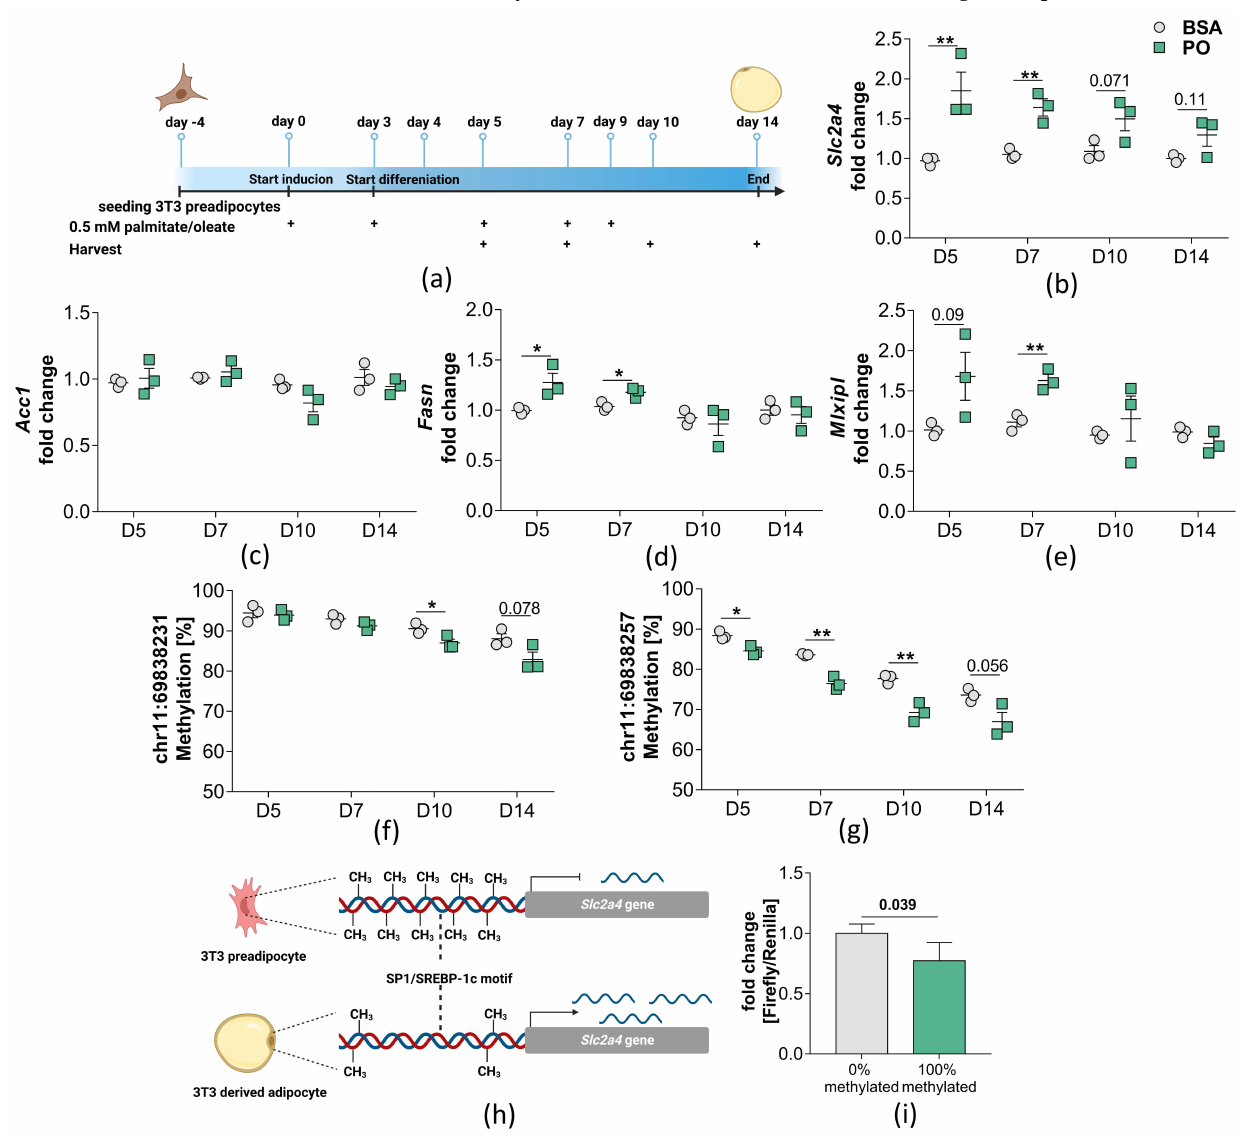
Figure 4. Gene expression and DNA methylation in 3T3 cells after treatment with palmitate/oleate. ( a ) Treatment regime of 3T3 cells during differentiation with either 0.5 mM palmitate/oleate (P/O, ratio 1:1) or 0.75% BSA (vehicle). 3T3 cells were seeded at D-4, start of induction of differentiation was performed at D0 and start of differentiation at D3. Crosses indicate time points of treatment. Cells were harvested at D4, D5, D7, and D10 for DNA and RNA extraction. ( b – e ) expression of genes involved in glucose uptake ( Slc2a1 , Slc2a4 ), glucose signalling ( Mlxipl ), and de novo lipogenesis ( Acc1 , Fasn ). Mean ± SEM of fold change between P/O treatment ( n = 3) and BSA treatment ( n = 3) is shown, after normalizing expression to Hprt. A Two-Way ANOVA was performed with, * = p < 0.05, ** = p < 0.01 ( f , g ) DNA methylation in the ROI under palmitate/oleate treatment or vehicle. Mean ± SD A Two-Way ANOVA was performed with * = p < 0.05, ** = p < 0.01. ( h ) Scheme on how DNA methylation may impair transcription factor binding and influence gene expression; ( i ) Methy- lation sensitive reporter gene assay. ROI was amplified from genomic murine DNA and cloned into a CpG-free reporter gene vector. Afterwards, ROI was methylated using a DNA methyltransferase and the vector was transfected into HEK293T cells. Displayed is mean ± SD after normalizing to 0% methylated as control. For statistical analysis unpaired, two-sided students t-test was